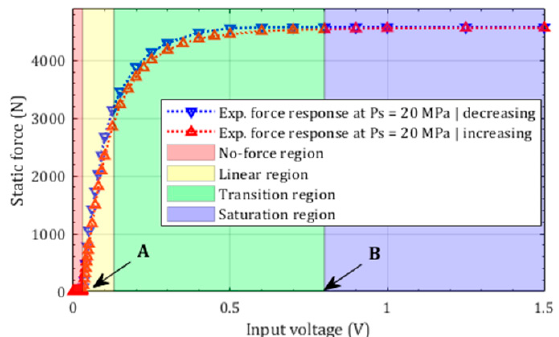
Figure 7. Classification of the measured force-voltage characteristics into four distinct regions.